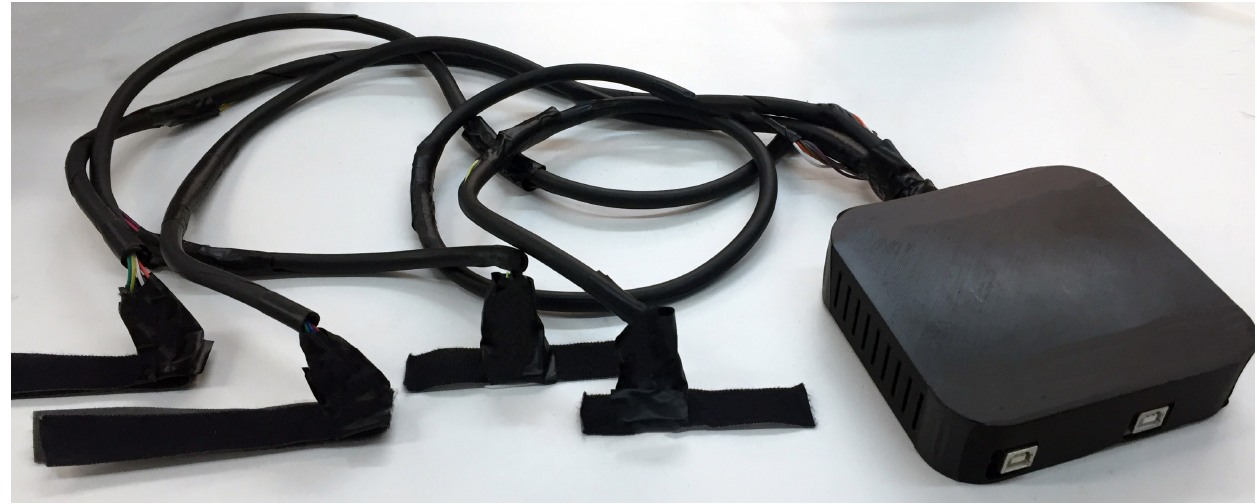
Figure 6. Graphical representation of the selected accelerometer placement points on the human hand for the presented ( A ) index and ( B ) metacarpal implementations of the exoskeletal glove.